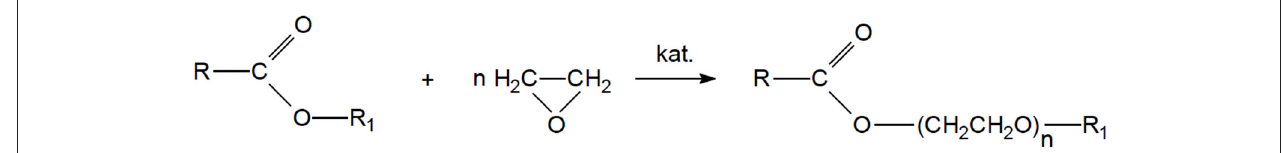
FIGURE 1 | General scheme of the ester ethoxylation reaction.